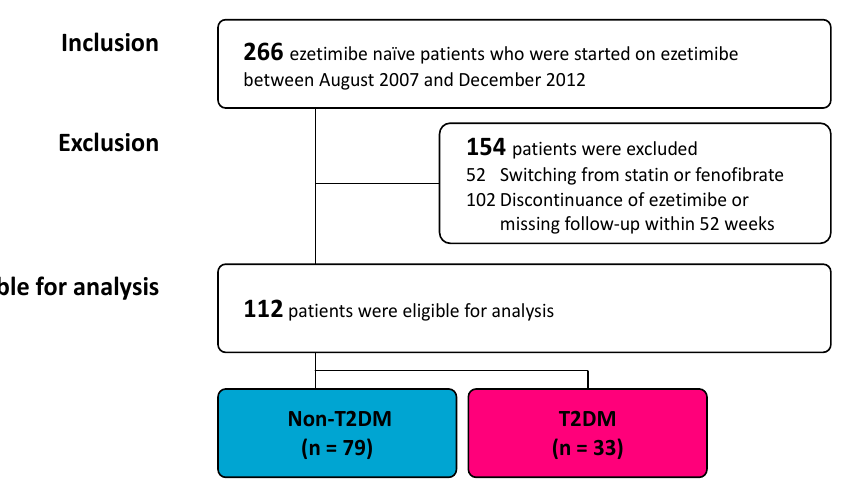
Figure 1. Flowchart of enrollment. T2DM, type 2 diabetes mellitus.